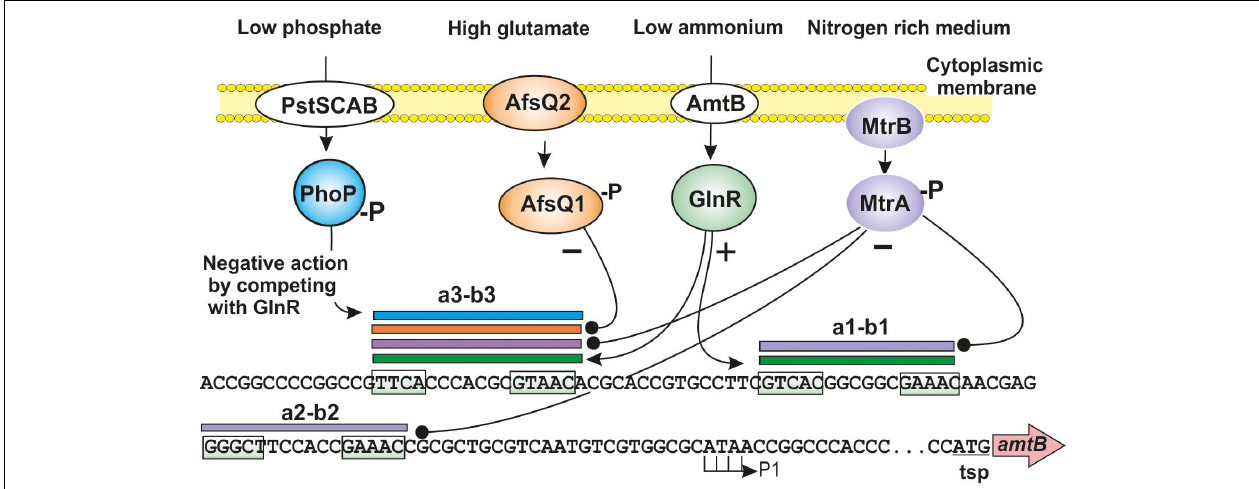
FIGURE 2 | Signal integration sites upstream of S. coelicolor amtB gene. Interaction of the regulatory proteins GlnR (green sphere), PhoP (blue sphere), MtrA (purple sphere), and AfsQ1 (orange sphere) on the amtB promoter region. The binding sites of GlnR, PhoP, MtrA, and AfsQ1 on the a1-b1, a2-b2, and a3-b3 sites are indicated with green, blue, purple, and orange horizontal bars, respectively. The transcription start point (P1) and the translation start point (tsp) of amtB are indicated. Positive regulation is indicated by arrows and negative regulations by black spheres. The consensus GlnR binding sequences are boxed. See text for additional